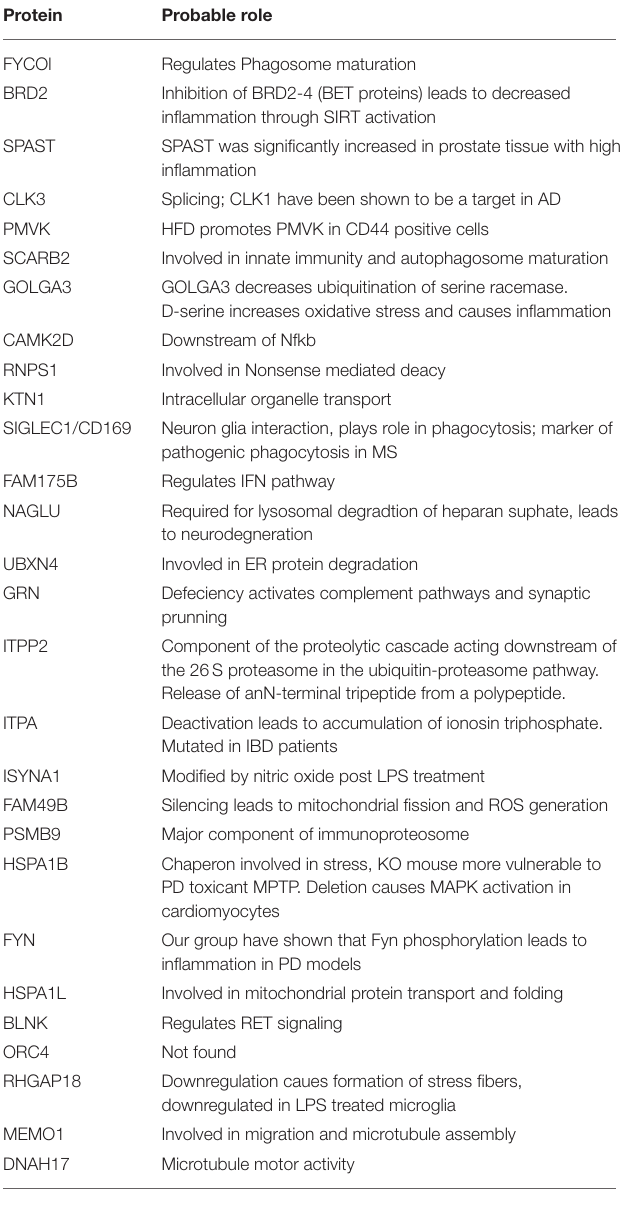
TABLE 3 | Concordance between differentially expressed genes in human PD and proteins in α Syn Agg -treated microglia (related to Figure 4C ). Protein